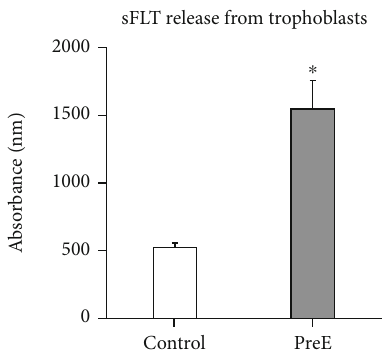
Figure 1: Soluble Flt release was increased in late onset preeclampsia ( p ≤ 0 : 05 , n = 4